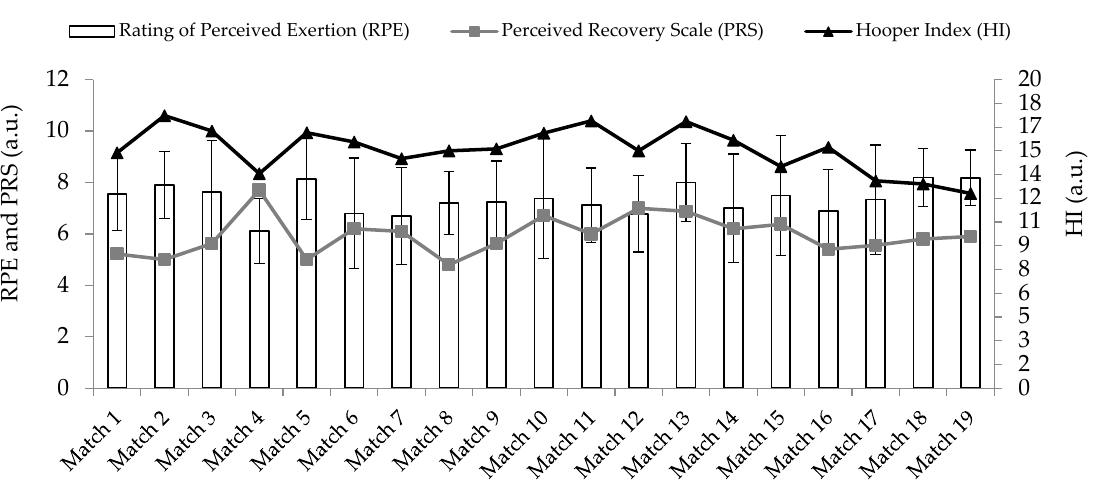
Figure 1. Trends of RPE, PRS and HI scores across the season. Table 3 presents the significant main effects found. For s ‐ RPE, the pairwise comparisons showed significative effects in match outcomes ( p ≤ 0.05), showing that drawn matches led to higher s ‐ RPE (mean ± SE = 277 ± 17.6 a.u.) than won matches (237.3 ± 20.6 a.u.) (mean difference = 39.7 ± 12.4 a.u.; p = 0.015; ES = 1.46, large). A significant effect of travel duration was found on s ‐ RPE (estimate = − 0.148), demonstrating how longer travel duration decreased the s ‐ RPE value. For playing time (estimate = 9.328), it was shown that higher playing times led to higher s ‐ RPE scores, while the higher number of goals scored (estimate = − 3.598) led to a lower s ‐ RPE score. No significant effect was found for playing position, season phase, match location, final score difference or goals conceded. Regarding PRS, a significative main effect was found for the final score difference ( p ≤ 0.05), with pairwise analysis showing that PRS was higher after balanced matches (mean ± SE = 6.8 ± 0.3 a.u.) compared to unbalanced matches (5.1 ± 0.4) (mean difference = 1.669 ± 0.362; p < 0.001, ES = 1.57, large). Significant effects for PRS were also found for playing time (estimate = − 0.041), for goals scored (estimate = − 0.180) and for perceived enjoyment (estimate = − 0.114), showing that higher levels of these factors decreased PRS scores. Differently, goals conceded (estimate = 0.138) had a positive impact on PRS. In this case, no significant effects were found for playing position, season phase, match location, match outcome, travel duration and RPE. For HI, significant effects were found for the season phase and match outcome (all p ≤ 0.05). Specifically, post-hoc pairwise comparisons demonstrated higher scores of HI in the regular season (mean ± SE = 15.6 ± 0.9 a.u.) compared to the play-out phase (13.5 ± 0.8 a.u.) (mean difference = 2.1 ± 0.5 a.u.; p < 0.001, ES = 0.78, moderate), as well as in won matches (mean ± SE = 16.1 ± 1.1 a.u.) compared to lost matches (13.9 ± 0.8 a.u.) (mean difference = 2.3 ± 0.9 a.u.; p = 0.049, ES = 0.90, moderate), and won matches in comparison with drawn matches (13.6 ± 1 a.u.) (mean difference = 2.5 ± 0.8 a.u.; p = 0.009, ES = 1.68, large), respectively. Furthermore, significant effects for HI were found for RPE (estimate = 0.266), showing that a higher value of match RPE led to a higher HI score at the beginning of the week. No significant effects were found for playing position, match location, final score difference, travel duration, playing time, goals scored, goals conceded and perceived